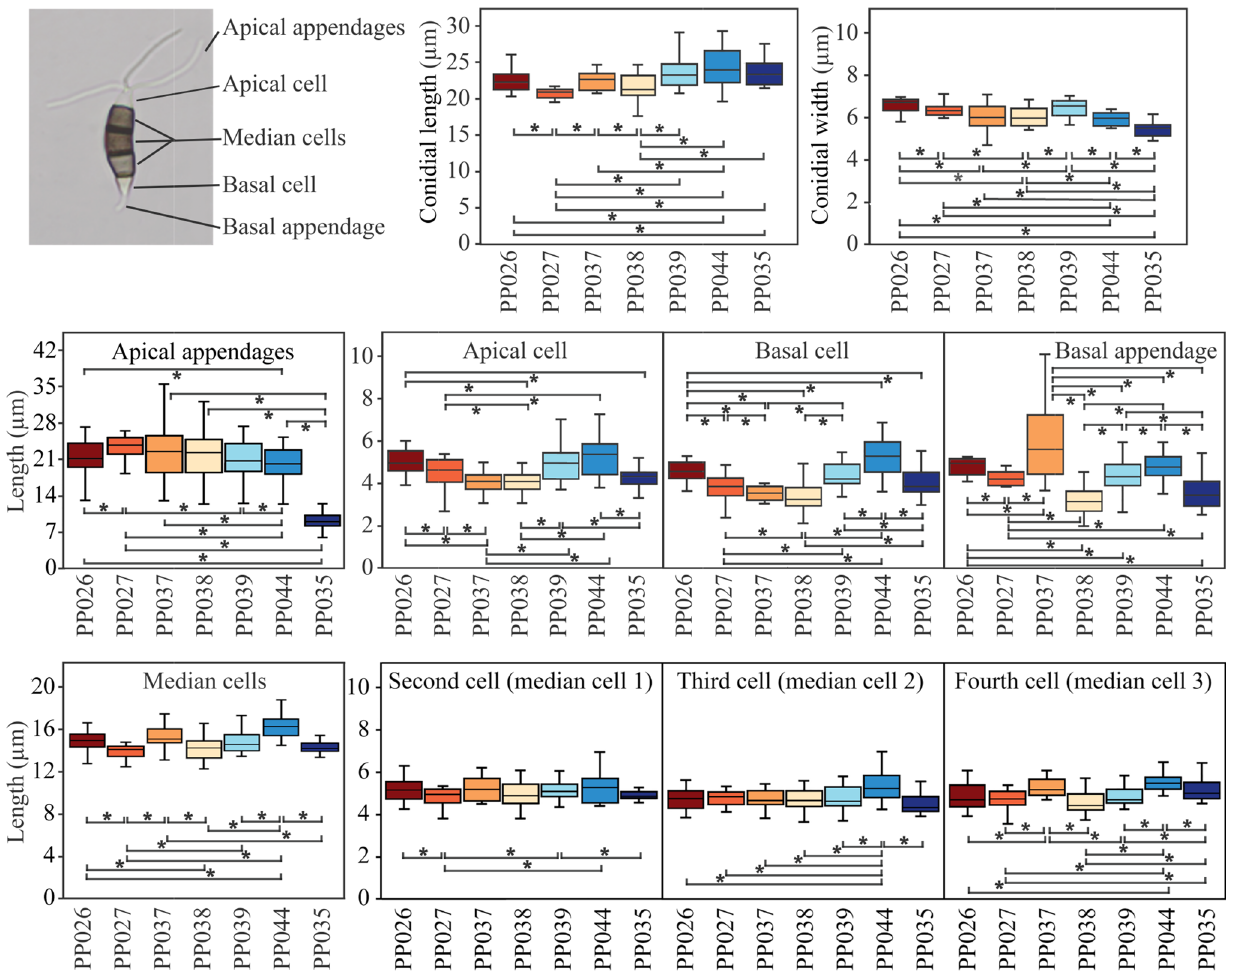
Figure 3. Conidial sizes of Neopestalotiopsis (PP026, PP027, PP037, PP038, PP039, and PP044) and Pseudopestalotiopsis (PP035). The upper-left corner represents conidial cells that are measured. Box plots are from the measurements of 20 conidia per isolate. Brackets with asterisks denote pairs differing at P <